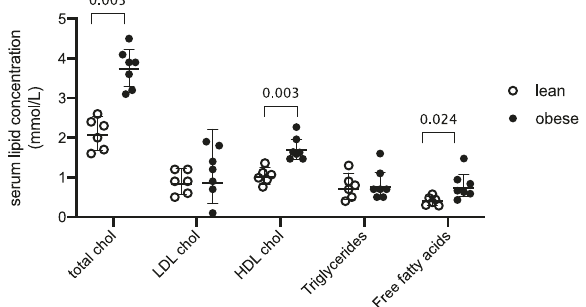
Fig. 3 Lipoprotein, cholesterol and triglyceride measures. Deter- mined using standard clinical bioassays. Values given in Table S1. The p values for comparisons given above braces between distributions. Chol,